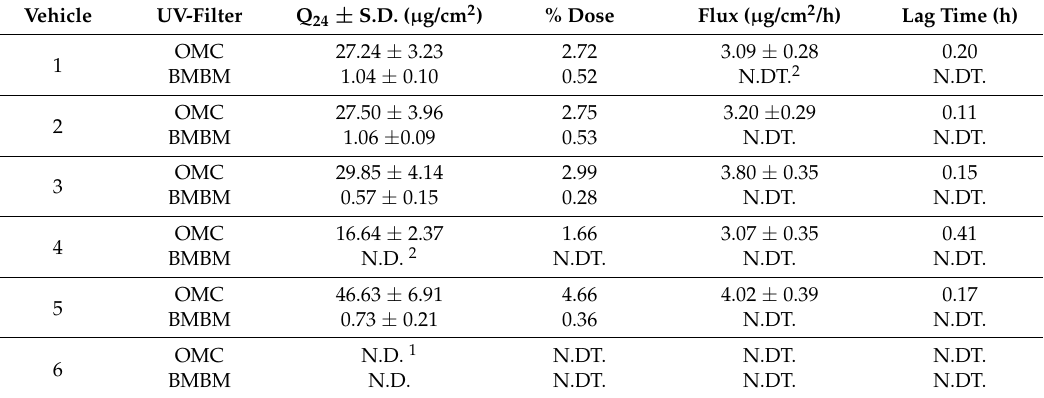
Table 6. In vitro skin permeation of OMC and BMBM from vehicle 1–6 after a single application: cumulative amount permeated after 24 h (Q 24 ± S.D.), percentage of dose permeated after 24 h (% D), flux through the skin (flux ± S.D.) and lag time.